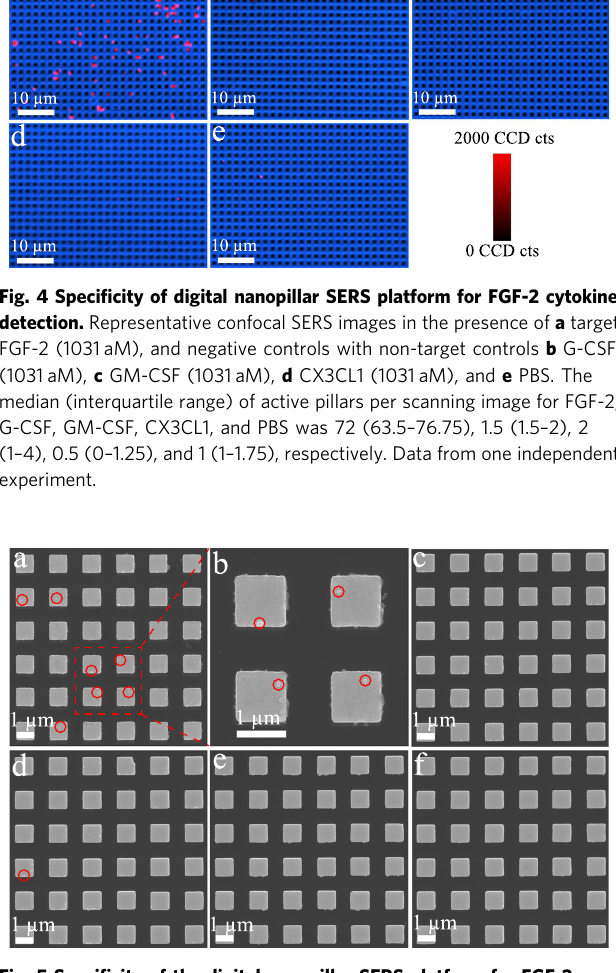
Fig. 5 Speci fi city of the digital nanopillar SERS platform for FGF-2 cytokine detection. Representative SEM images of pillar array incubated with FGF-2 SERS nanotags in the presence of a , b FGF-2 (1031 aM), c G-CSF (1031 aM), d GM-CSF (1031 aM), e CX3CL1 (1031 aM), and f PBS. The red circles highlight the existence of SERS nanotags. Panel b is the magni fi ed SEM image of the red-highlighted section in a . It is noted that nanofabrication debris on the sidewall of the pillars can also be seen. Data from one independent experiment.